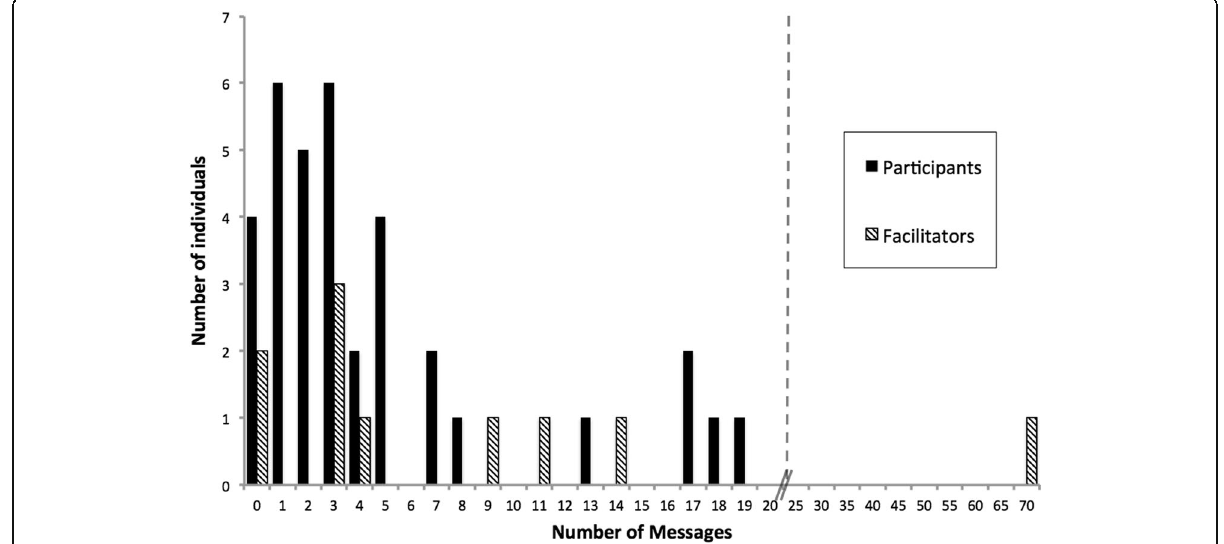
Fig. 4 Frequencies of individuals ’ activity on group email list ( n = 46, 35 participants and 11